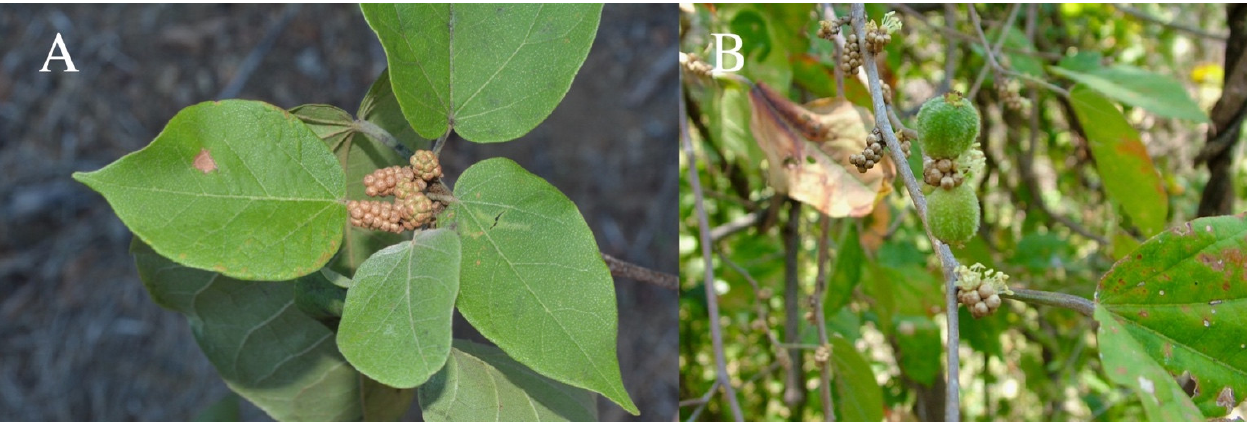
Figure A8. Croton lindquistii. ( A ) Branch with flower buds. ( B ) Branch with flowers and fruits. B photographed by Ignacio Ruiz and used with